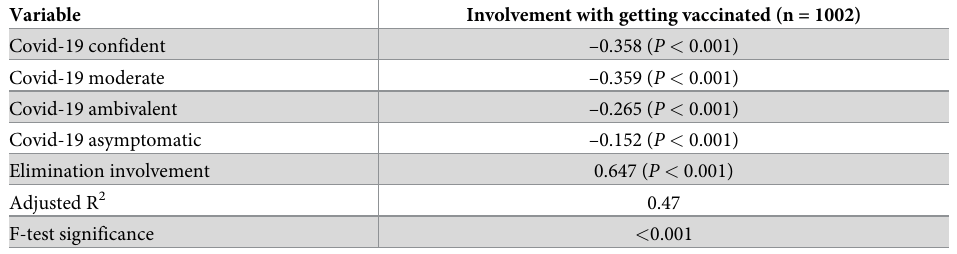
Table 12. Estimates of standardised parameters for involvement with Covid-19 vaccination.